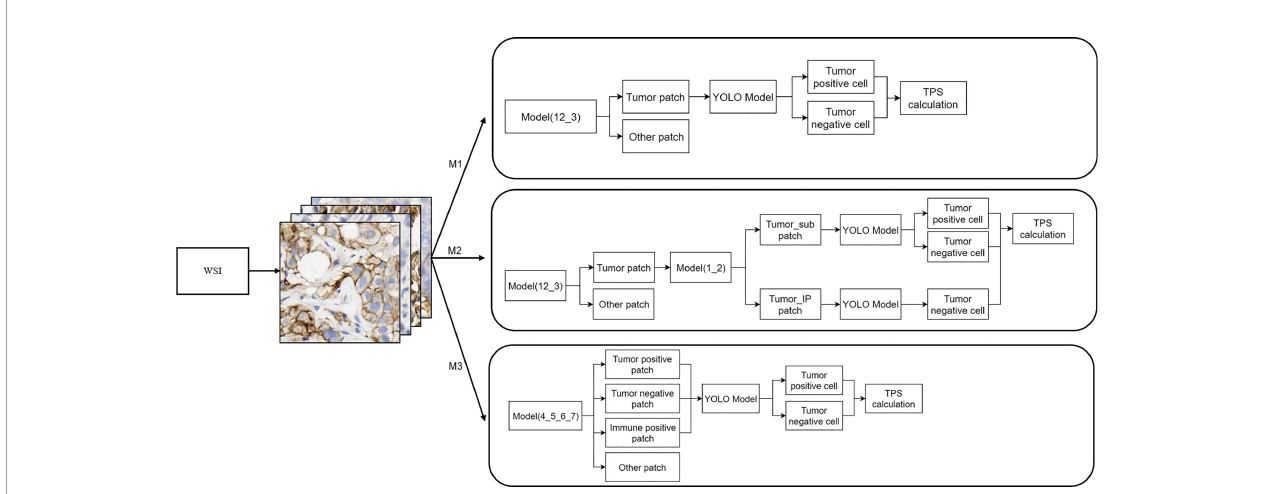
FIGURE 3 | Whole-slide image inference work fl ow. A whole-slide image was analyzed with different arti fi cial intelligence model-based work fl ows (M1, M2, and M3). The detailed information of these three work fl ows is shown